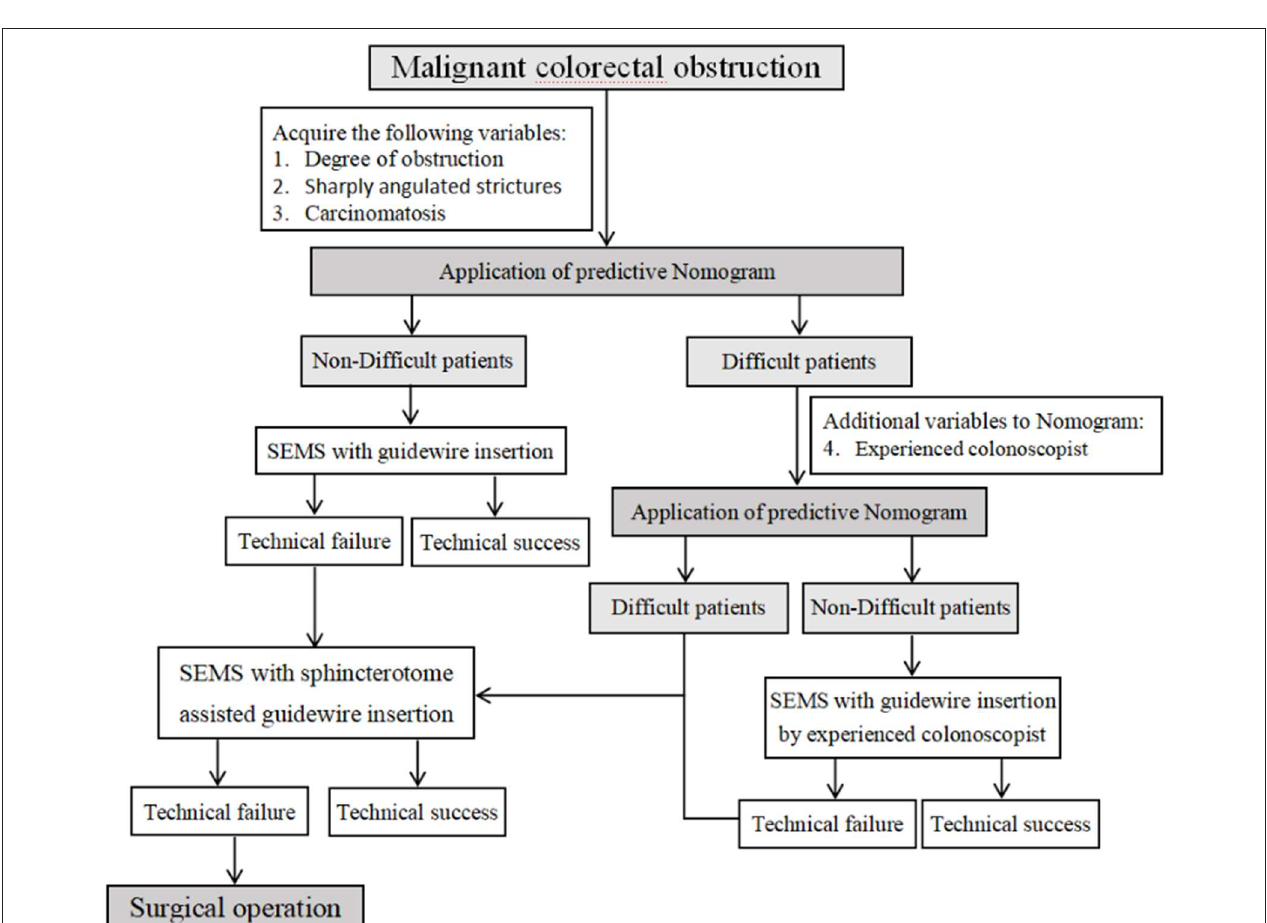
FIGURE 5 | Algorithm for treating malignant colorectal obstruction with self-expandable metal stent placement.